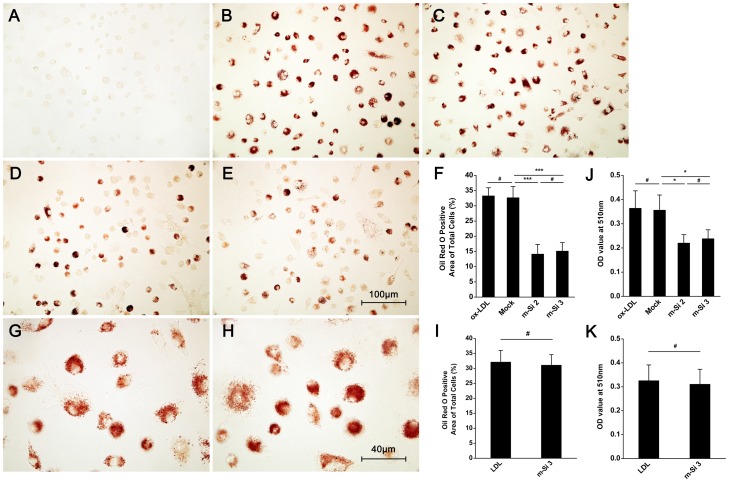
Siglec-1 knockdown can attenuate oxLDL uptake by macrophages.BMMs were cultured for 6 days and transfected with mock siRNA (C) or siRNA targeting Siglec-1 (D, E, H), 24 h later, oxLDL 100 µg/ml (B∼E) or LDL 100 µg/ml (G∼H) was added and stimulated for 48 h. Then Oil red O staining was performed (A∼E, G∼H). Red particles in the cytoplasm indicated Oil red O positive lipid. A, control; B, oxLDL 100 µg/ml; C, mock transfection; D, m-si 2; E, m-si 3. Magnification ×400 (A–E). (F), Statistical analysis of A–E, randomly 20 highpower fields were selected in each group. #p>0.05, ***p<0.001. (G), native LDL 100 µg/ml was used as control. (H), LDL 100 µg/ml+m-si 3. Magnification ×1000 (G–H). (I), Statistical analysis of G–H. #p>0.05. (J), Quantitation of Oil red O staining in B–E with a spectrophotometric method. #p>0.05, *p<0.05. (K), Quantitation of Oil red O staining in G–H. #p>0.05.